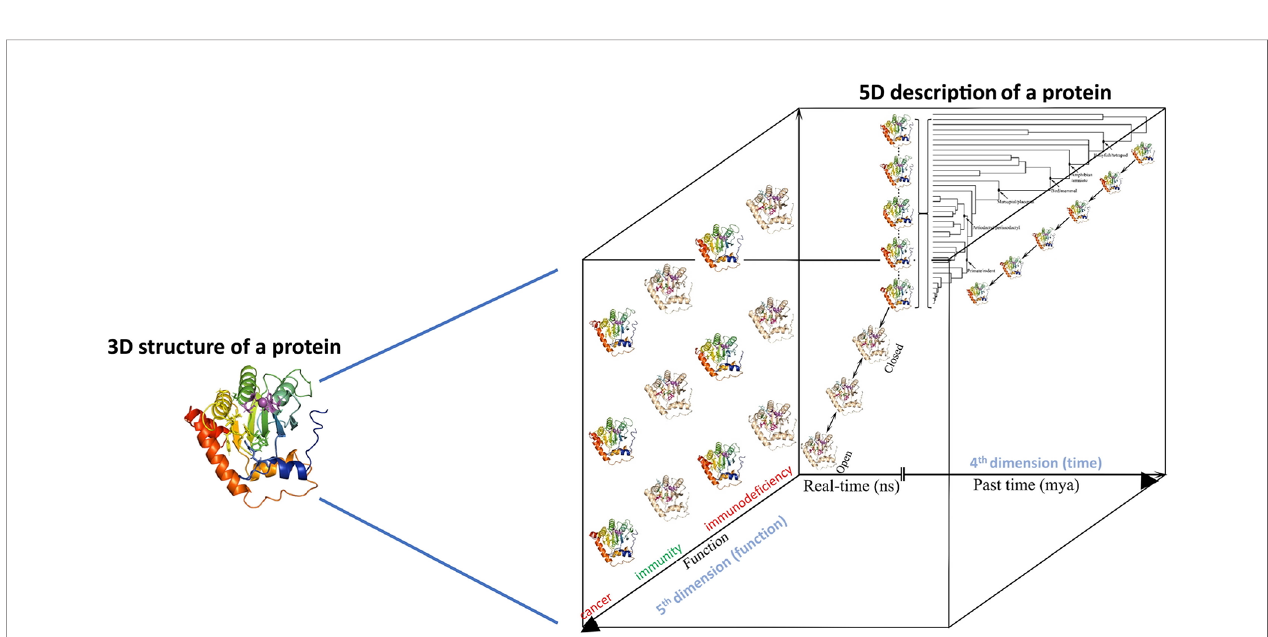
FIGURE 3 | 5-dimensional description of biological molecules. In the 5D structure description proposed here, the information from the traditional 3D structure is combined with the structure dynamics in time (4 th dimension = time, in real time measured in fractions of a second, and evolutionary time measured in millions of years) and integrated with how these real-time and evolutionary dynamic structural changes impact the biological function of the protein (5 th dimension = biological function as dependent on 3D and 4D descriptions of a protein ’ s